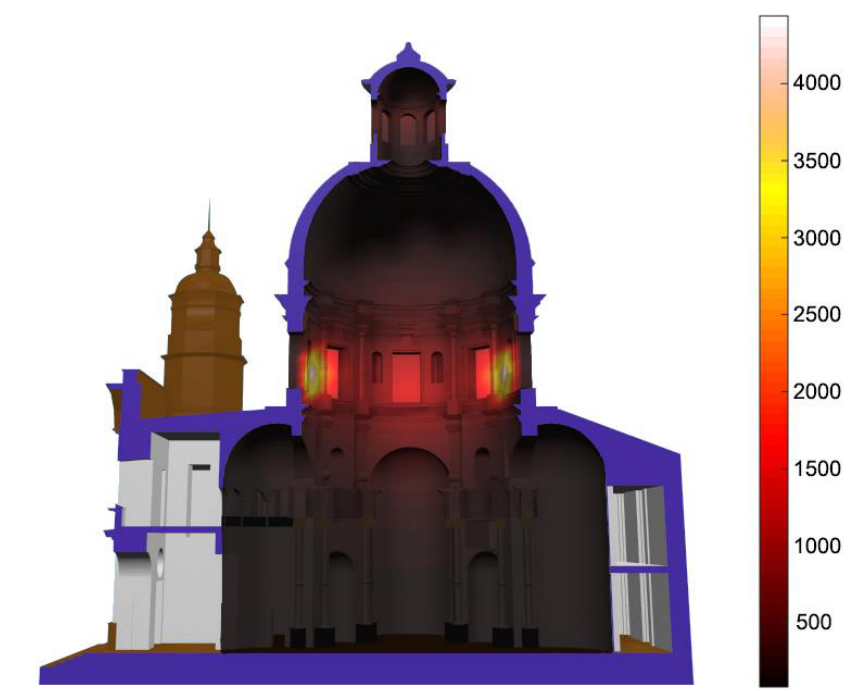
Figure 8. Daylight section on the 21st of September in a cloudy day. Maximum values of 200 lux appear in the lower levels of the space. Source: Cabeza-Lainez.